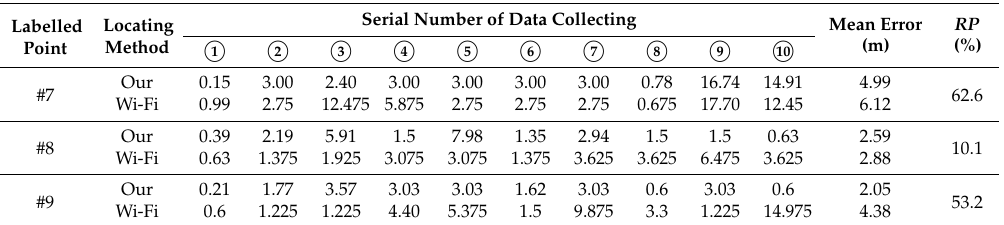
Table 10. Positioning errors (in meters) of the proposed approach (abbreviated as “Our” in the table) and Wi-Fi in indoor